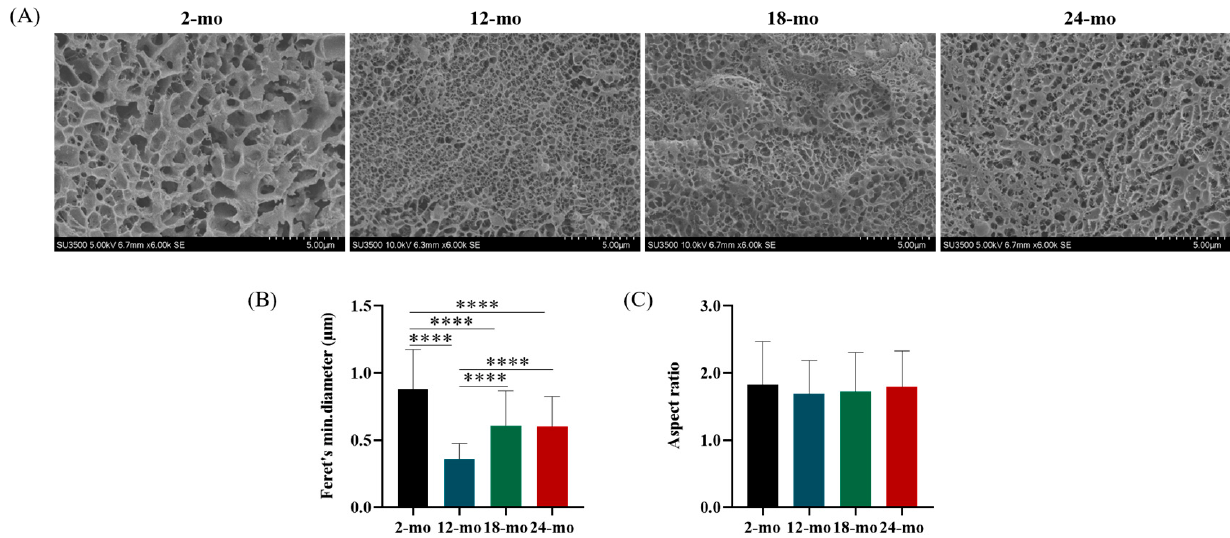
Figure 2. Microstructural characteristics of colonic mucus in mice. ( A ) Representative cryo-scanning electron micrographs of colon mucus at different ages (scale bars: 5 µ m). ( B , C ) showed the Feret’s minimum diameter and aspect ratio distribution of mucus pores, respectively. At least 100 pores per micrograph were identified and used in the analysis. Data were presented as mean ± SD. Data were statistically analyzed using one-way ANOVA with Tukey’s post hoc test. Asterisk indicates significant difference, **** p < 0.0001, n = 3 per group.